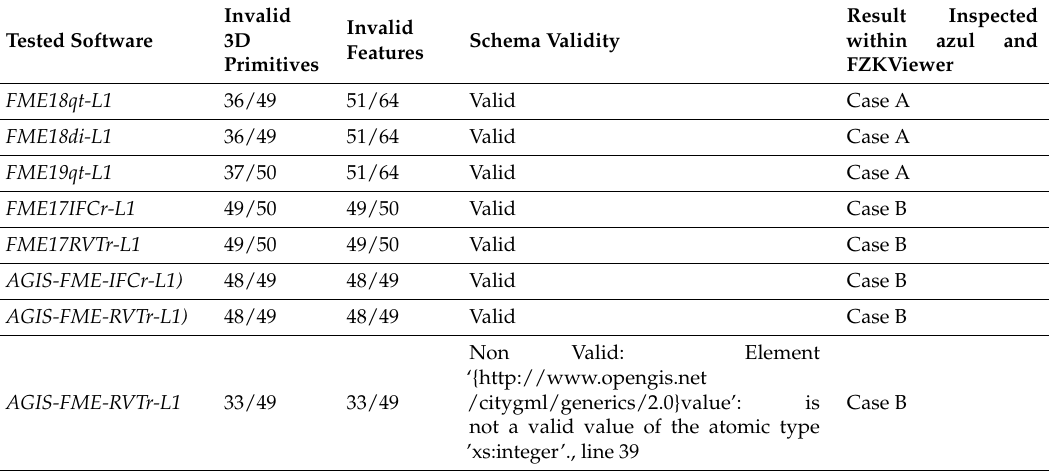
Table 11. Analysis of the IFC geometries dataset, in IFC v.2x3 converted to CityGML. 1